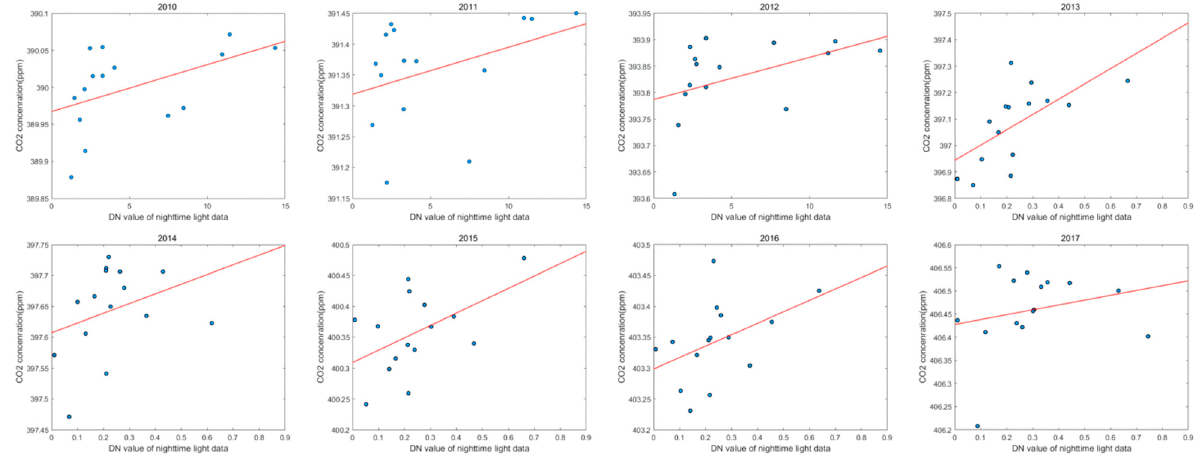
Figure A1. Correlation between annual NL data and CO 2 concentration of cities in Hubei province from 2010 to 2017.